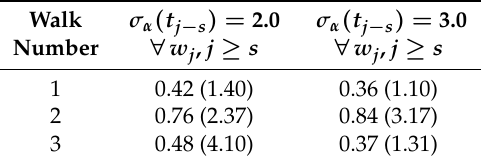
Table 5. Mean position error ¯ e and maximum error e max (in brackets) of 3 multi-sensor running walks with 6 sensors mounted on the foot starting in front of the building for partly successive FeetSLAM. The number of iterations was 3 and the window size was 3.